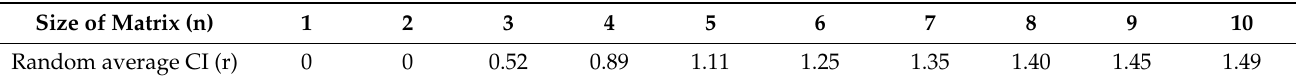
Table 3. Values of the consistency indexes [28].